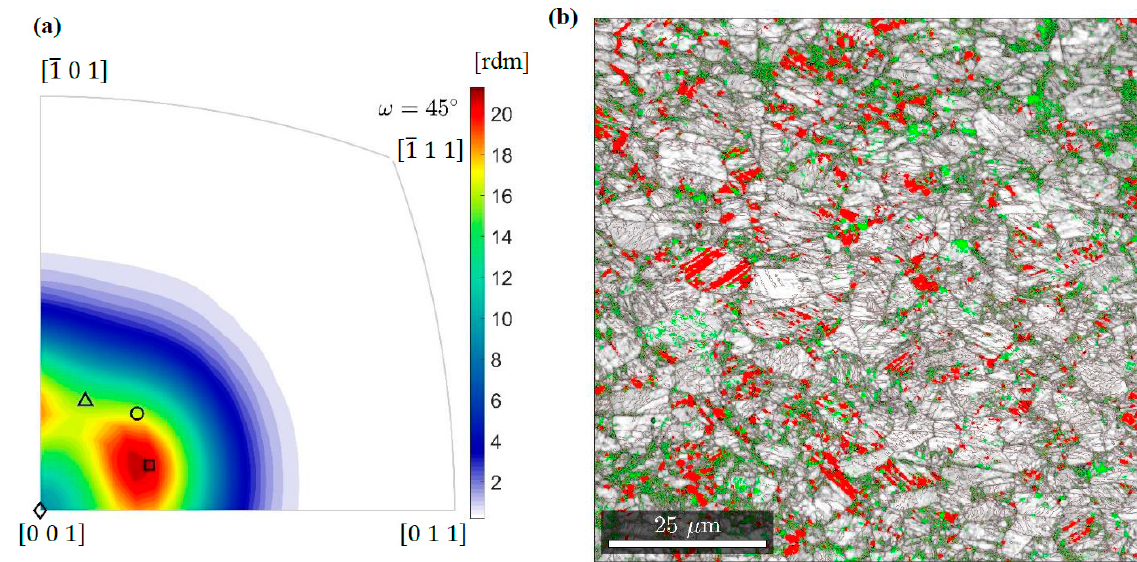
Figure 12. ( a ) MDF for austenite/ α ’martensite boundaries in the area 2 mm from the fracture surface with the key relations: Pitsch (square), Kurdjumov-Sachs (circle), Nishiyama-Wasserman (triangle), Bain (diamond). ( b ) Microstructure of the specimen area at the fracture surface: image quality map of α ’ martensite with grains of austenite (red) and ε martensite (green).